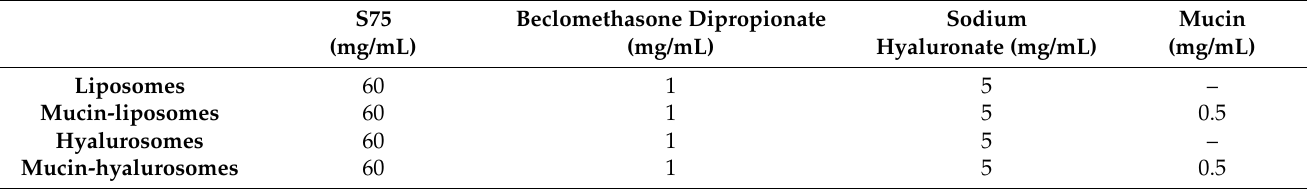
Table 1. Amount (mg/mL) of components used to prepare beclomethasone containing vesicles. S75